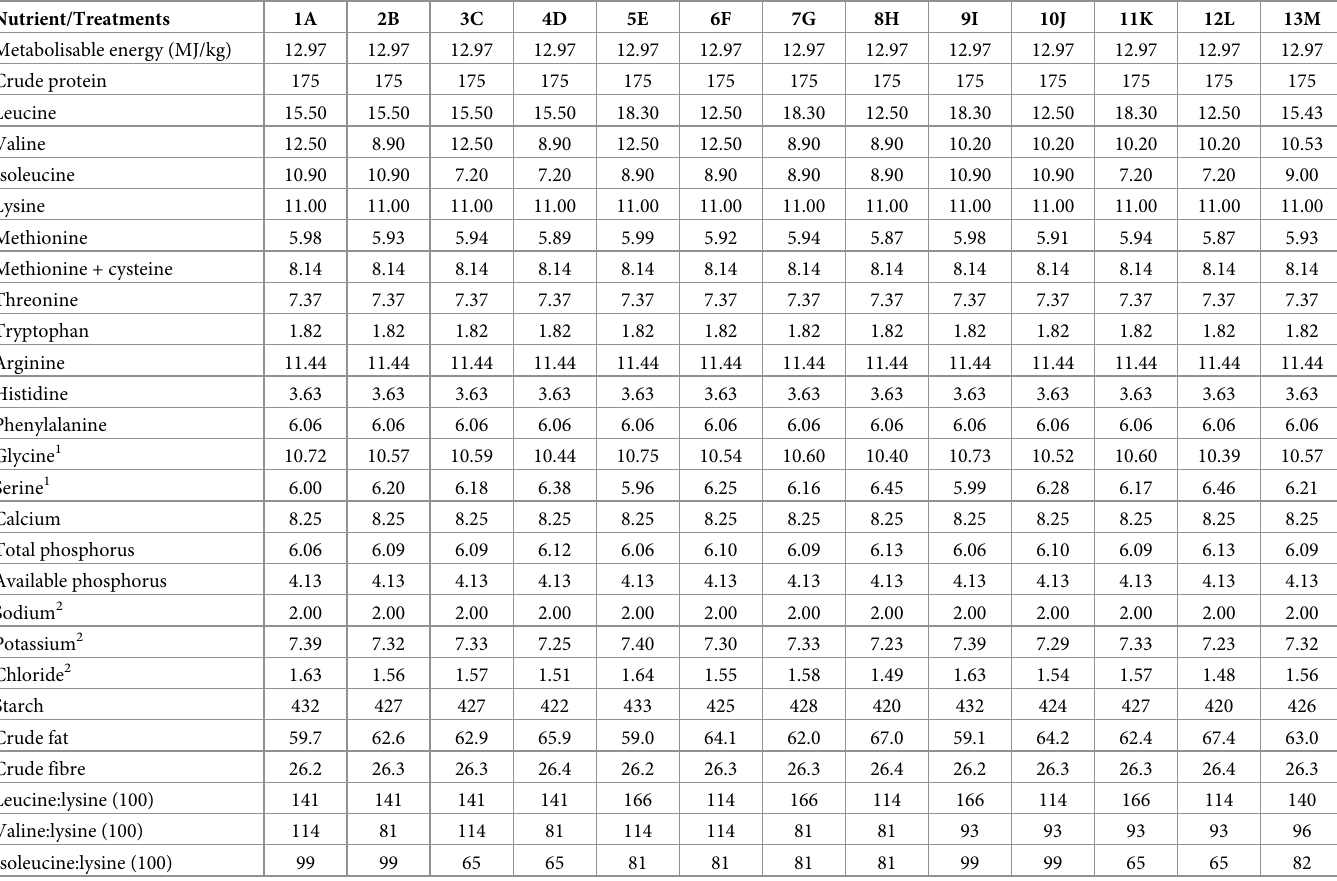
Table 4. Nutrient specifications (g/kg) of experimental diets where values for digestible amino acids are tabulated.